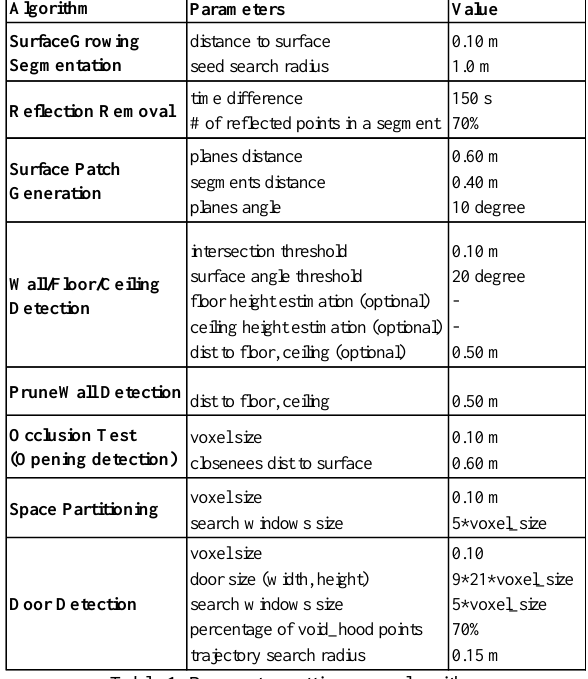
Table 1. Parameter settings per algorithm